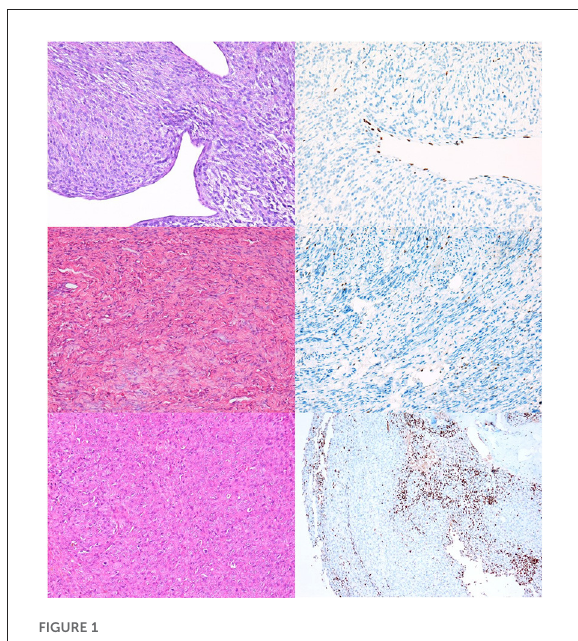
FIGURE2 NSTs with mosaic loss of H3K27me3 expression. (A,B) MNST with perineural differentiation. HE, 200x (A) , with loss of H3K27me3 expression in 50–94% of tumor cells, H3K27me3, 200x (B) . Conventional MNST, HE, 200x (C) , with loss of H3K27me3 expression in 5–49% of tumor cells, H3K27me3, 200x (D) . Nerve sheath myxoma, HE, 200x (E) , with loss of H3K27me3 expression in 5–49% of tumor cells, H3K27me3, 200x (F)